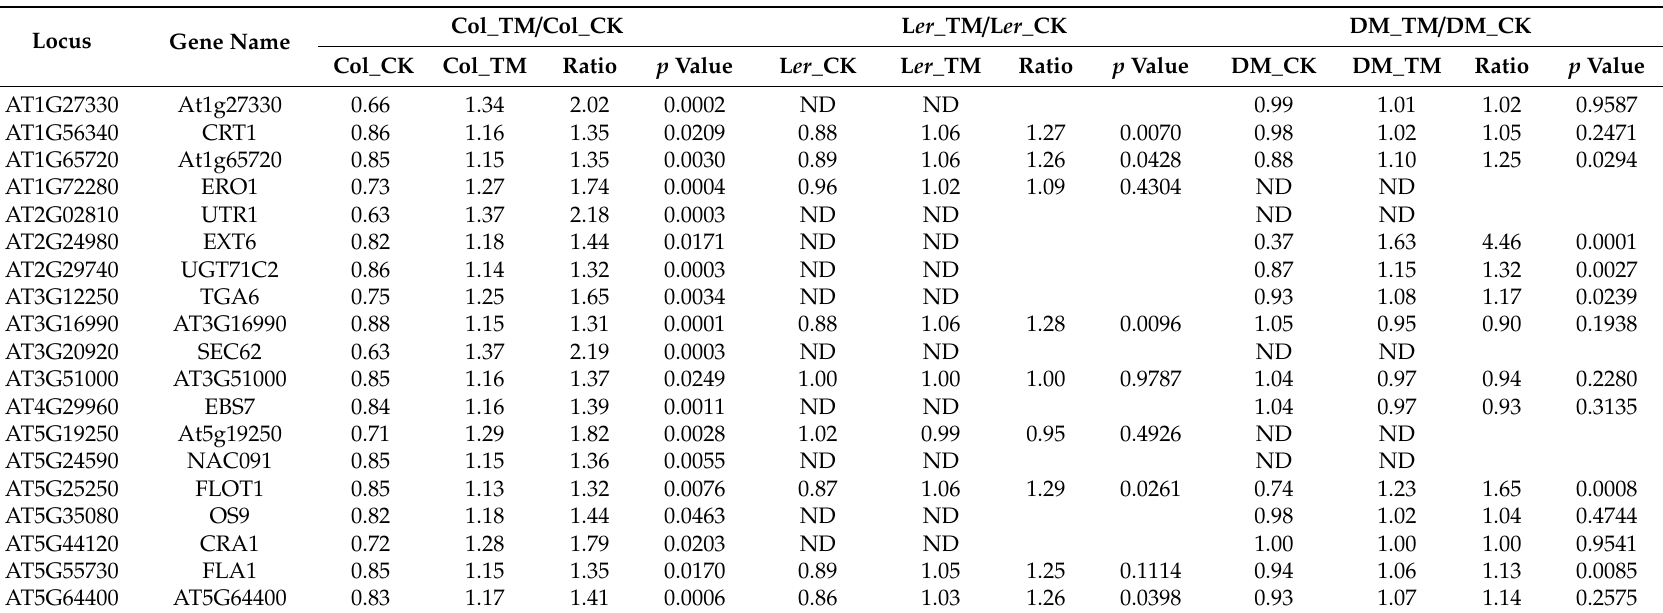
Table 3. Di ff erential upregulation of proteins by ER stress in Col, L er , and DM